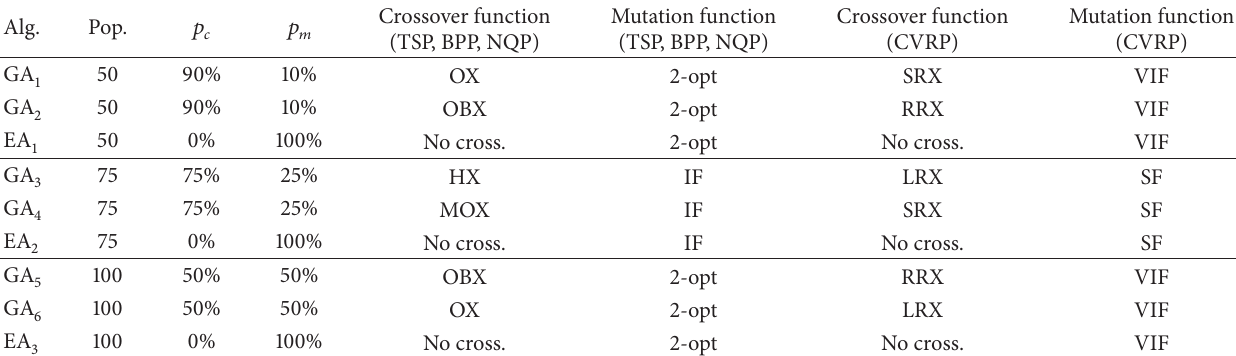
Table 1: Summary of the characteristics of all the techniques